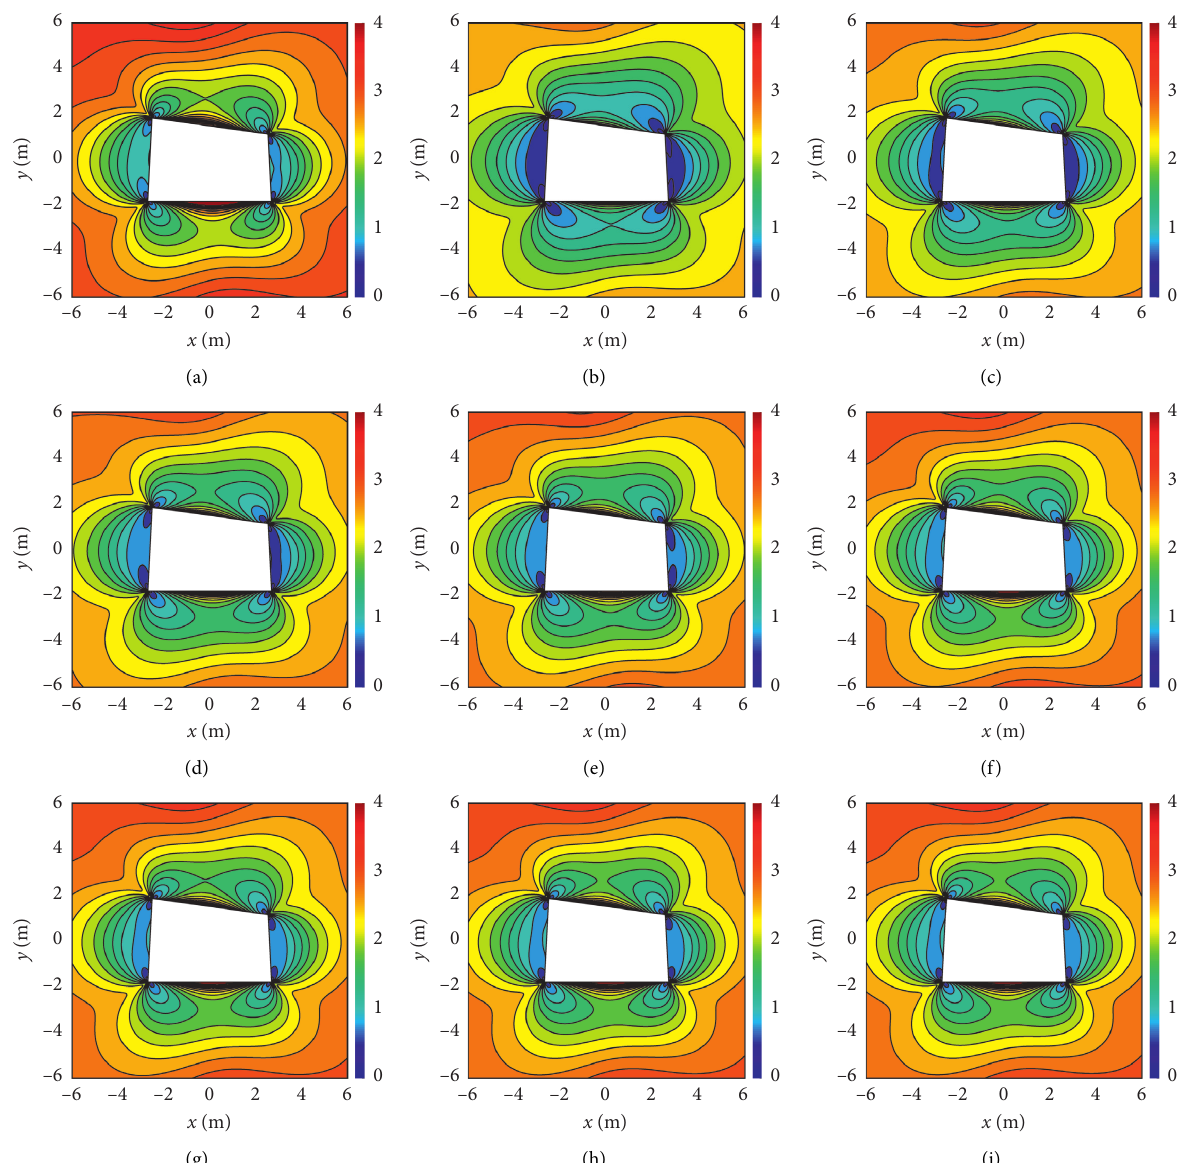
Figure 5: Contour map of SRSI at different distances from the working face. (a) l � 30m. (b) l � 60m. (c) l � 80m. (d) l � 100 m. (e) l �